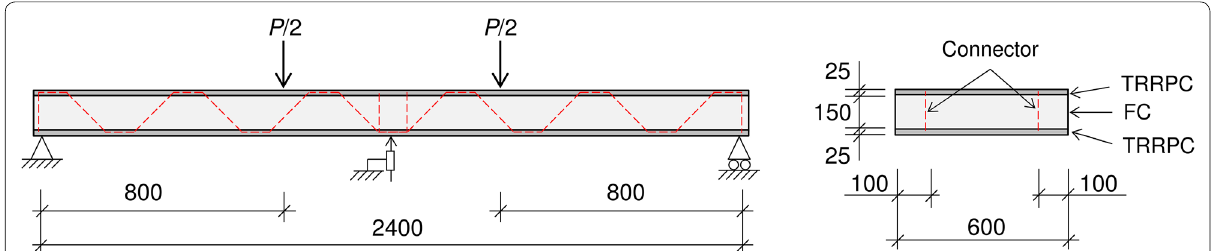
Fig. 7 Schematic of four-point bending test set-up and specimen